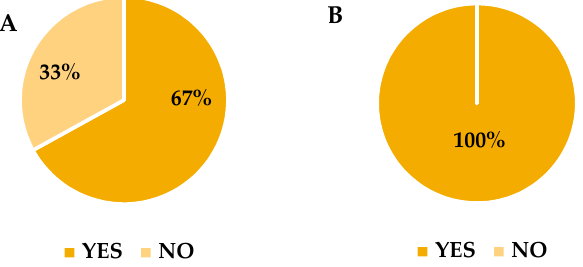
Figure 4. A pie chart showing the results of a triangle test between ( A ) an undegraded cheese sample and ( B ) a degraded cheese sample.